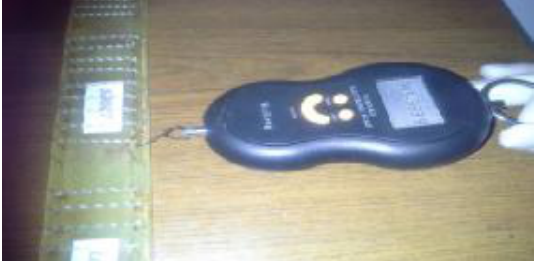
Figure 1: Force measurements